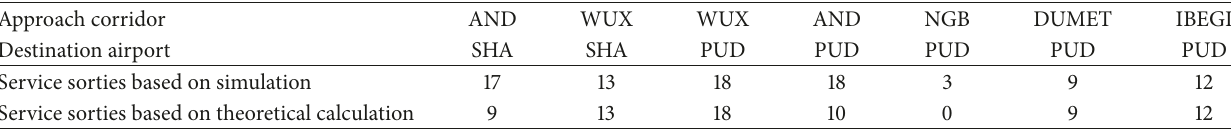
Table 9: Approach route capacity comparison between simulation data analysis and theoretical calculation for the fifth flight path in one